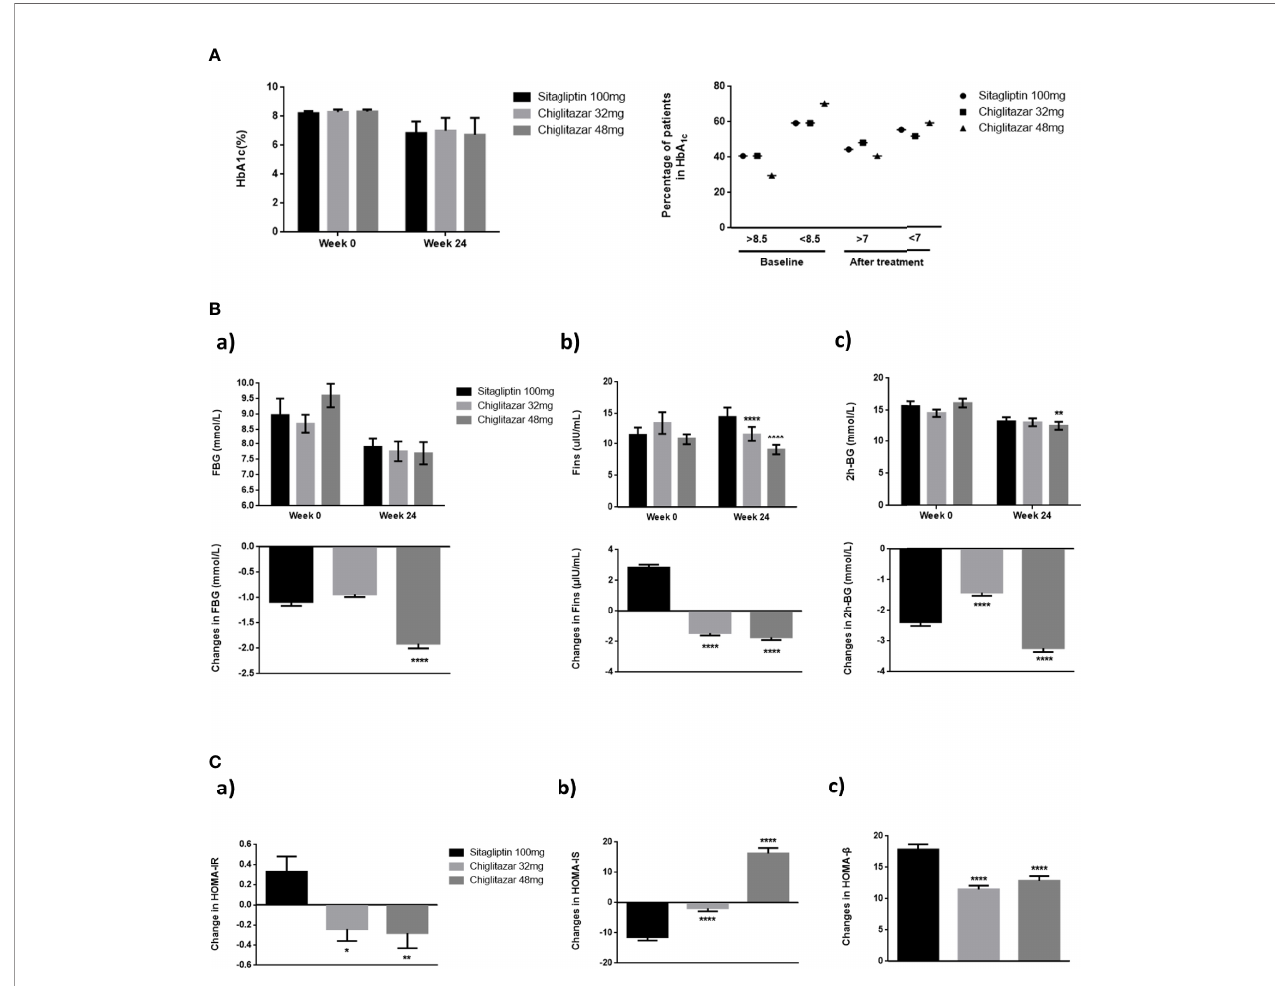
FIGURE 2 | Changes of glycaemic control parameters in groups. (A) Mean HbA1c of groups from baseline to week 24, and percentage of patients who arrived HbA1c < 7%. (B) Mean FBG, Fins, and 2 h-BG of groups from baseline to week 24. (C) Changes of HOMA-IR, HOMA-IS, and HOMA- b from baseline to week 24. *P < 0.05, **P < 0.01, ****P < 0.0001. Error bars show standard error of the mean